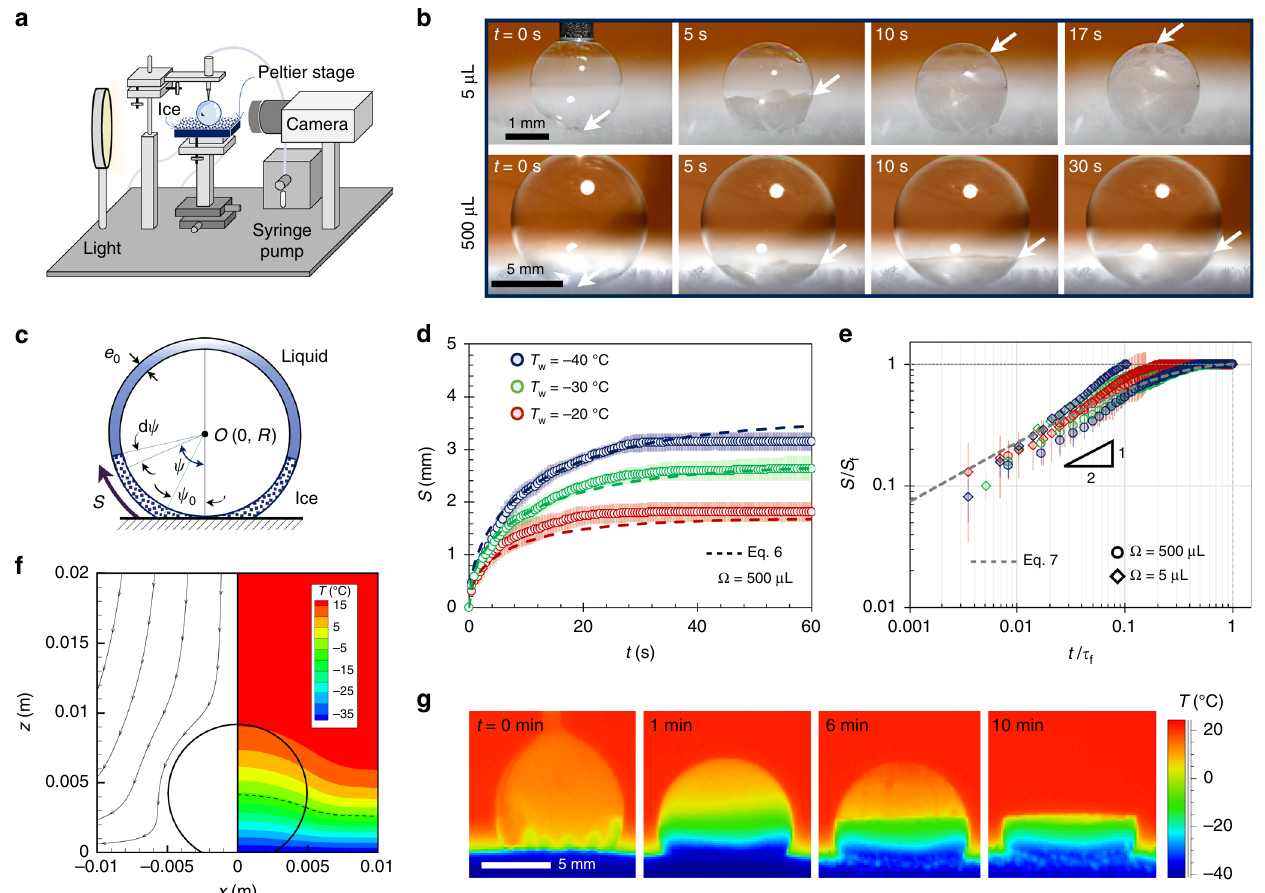
Fig. 4 Freezing bubbles on a cold stage in a room-temperature environment. a Schematic of the experimental setup, where a bubble of controlled volume is deposited on a frosted Peltier substrate using a syringe pump. b Side-view imaging of freezing bubbles, of volume Ω = 5 μ L and Ω = 500 μ L on a surface chilled at T w = − 40 ± 1 °C. Arrows indicate the evolving location of the freeze front and time zero is when the bubble is fi rst deposited. c Schematic showing the terms used in Eq. 6. d The frozen arc length of Ω = 500 μ L bubbles over time. Data points (circles) represent experimental data, with error bars of one deviation across three trials, while dashed lines represent Eq. 6. e For both Ω = 5 μ L (diamonds) and Ω = 500 μ L (circles), plotting the frozen arc length normalized by the fi nal arc length ( S / S f ) against a nondimensional timescale ( t / τ f ) collapsed all of the data onto a universal curve (Eq. 7). The average ambient conditions across all experiments were T ∞ = 23.4 ± 1.2 °C and a relative humidity of RH = 42 ± 14%. f Simulation of the air temperature pro fi le shows that near the center of the Peltier, the bubble somewhat disrupted the natural convection, resulting in greater slopes for the iso-temperature lines (see Supplementary Fig. 8). The dashed line corresponds to T = − 6 °C. g Thermographic images of a Ω = 500- μ L bubble deposited on a